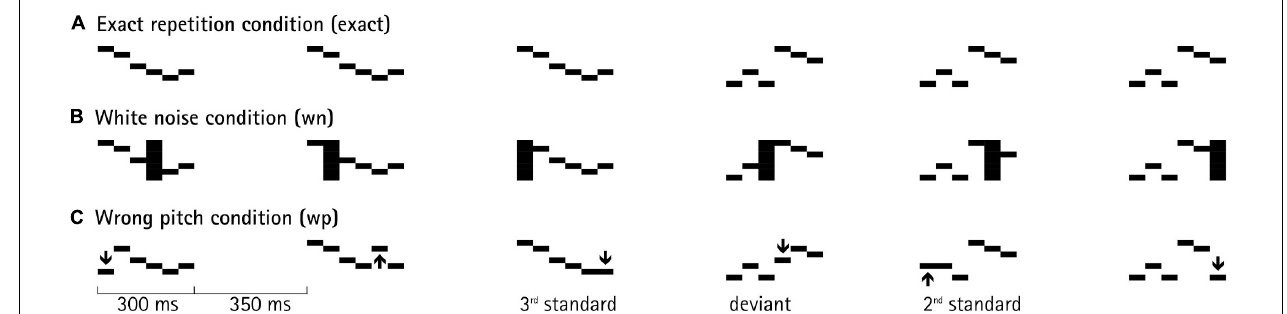
FIGURE 1 | An example of a pattern sequence, in which patterns were presented in a roving-standard paradigm. At the third position, the pattern has been presented three times; before, at the fourth position, a new train started with a new sound pattern (deviant), which, itself, is repeated within that next train. Each deviant corresponds to a first standard of a new train. Each pattern was composed of six concatenated 50-ms segments, differing in fundamental frequency (black horizontal bars). SOA (stimulus onset asynchrony) was set to 650 ms (= 300-ms pattern duration + 350-ms interstimulus interval). The top line (A) depicts the identical repetition of a sound pattern within a train in the exact-repetition condition. The middle line (B) depicts the white-noise-distortion condition, in which a randomly chosen segment of each sound pattern was replaced by white noise, marked with the black vertical bar. The bottom line (C) depicts the wrong-pitch condition, in which a randomly chosen segment of each sound pattern was replaced by a new segment of randomly chosen new pitch, indicated by the